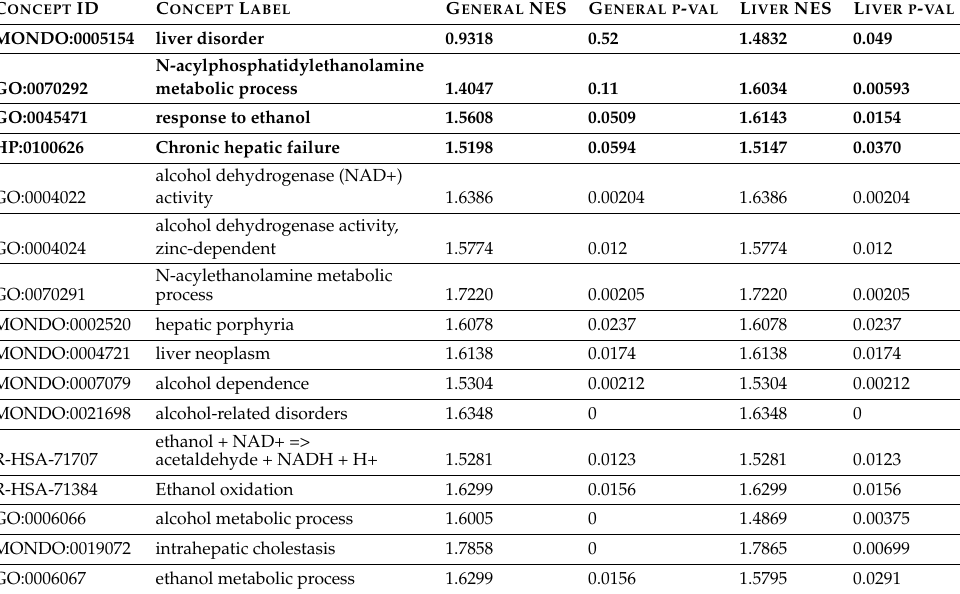
Table 2. Comparison of concept enrichment score between gene sets derived from the general KG vs. gene sets derive from the liver KG. The first four rows correspond to concepts that are highly relevant to the alcoholic hepatitis study and only become statistically significant when using the liver KG.